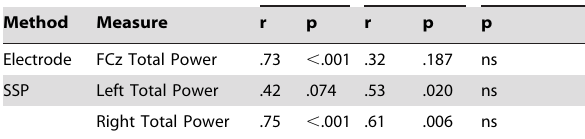
Table 3. Correlation values (Pearson’s r) between sessions 1 and 2 for the baseline normalized auditory steady-state response (40 Hz, 200–500 ms): Fourier